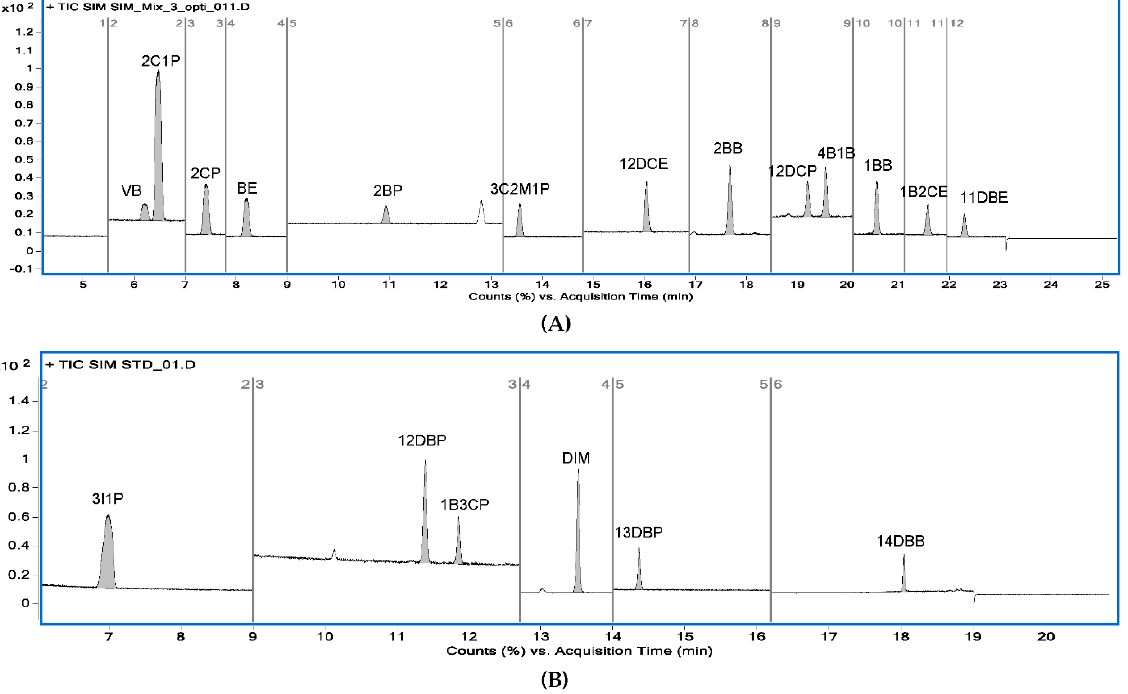
Figure 9. Typical GC − MS chromatograms of 19 alkyl halides using the selected ion monitoring (SIM) mode. ( A ) Chromatogram for 13 alkyl halides obtained from method A; ( B ) chromatogram for 6 alkyl halides obtained from method B.